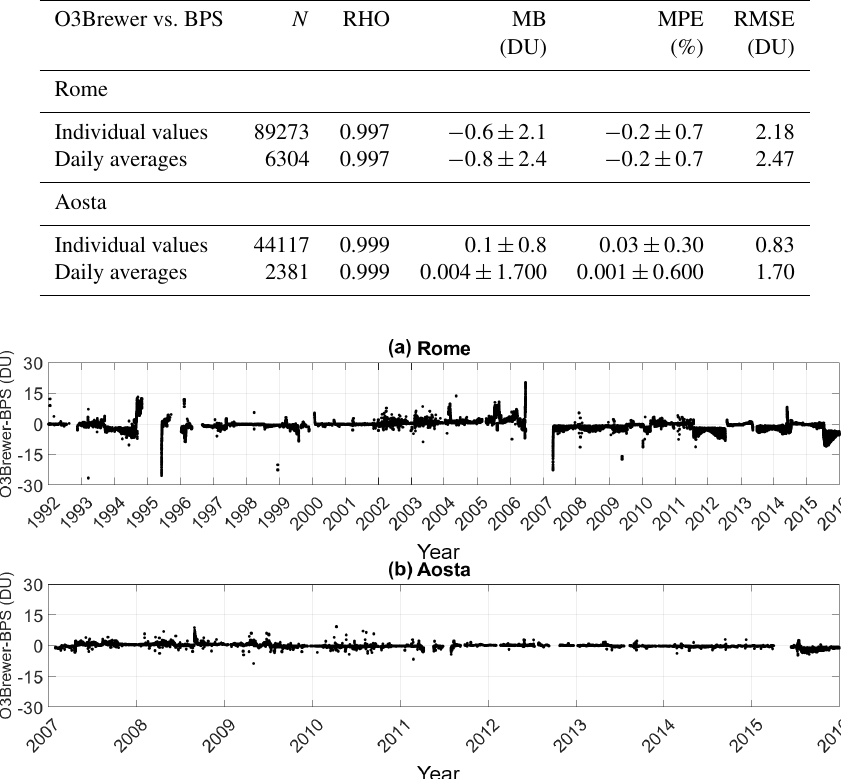
Figure 12. Difference between individual TOC values generated by BPS and O3Brewer at Rome (a) and at Aosta (b) when anomalous values were discarded. In O3Brewer the cut-off in R 6 was set to 500